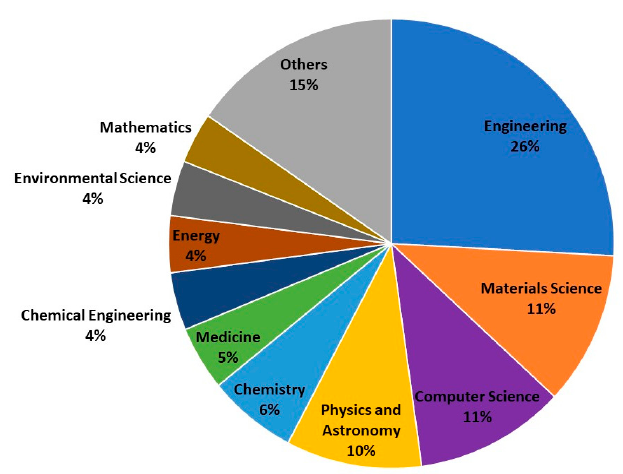
Figure 2. Distribution of low-cost publications by scientific categories indexed in Scopus.